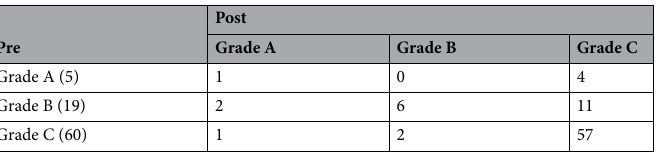
Table 4. Showing the change of the grade of the canine root and root apices from the pre- to the post- retraction position for the same subjects.